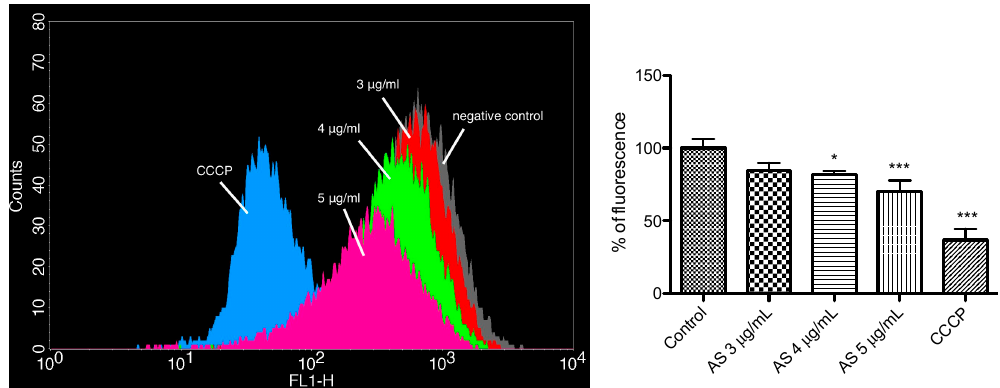
Figure 8. Mitochondrial membrane potential of T. b. brucei treated with 3, 4 and 5 μ g/mL of garlic extract (AS) for 6 h and stained with Rh123. Typical histograms of three independent experiments are depicted. * p ≤ 0.05, significant difference relative to the control group (untreated cells). P values are interpreted as: * p ≤ 0.05; *** p ≤ 0.001.